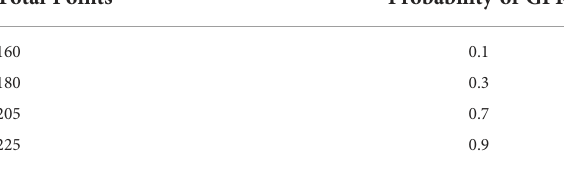
TABLE 20 GPR probability corresponding to different total scores in the